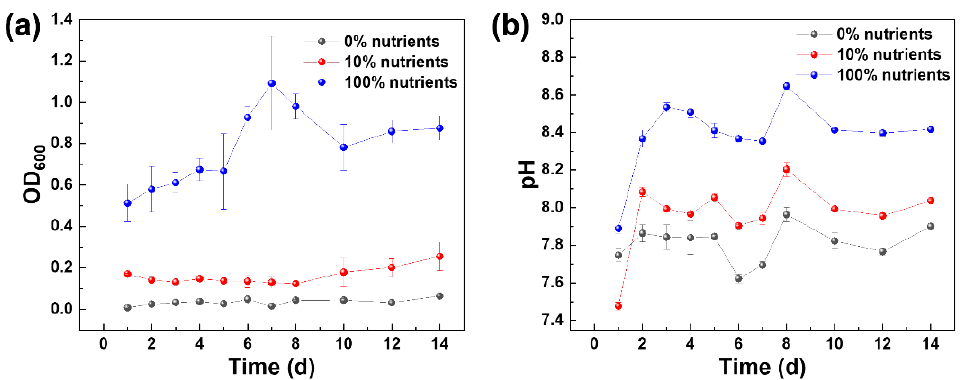
Figure 1. Change of ( a ) OD 600 value and ( b ) pH value with time in the P. aeruginosa − inoculated culture media with 100%, 10%, and 0% nutrients.